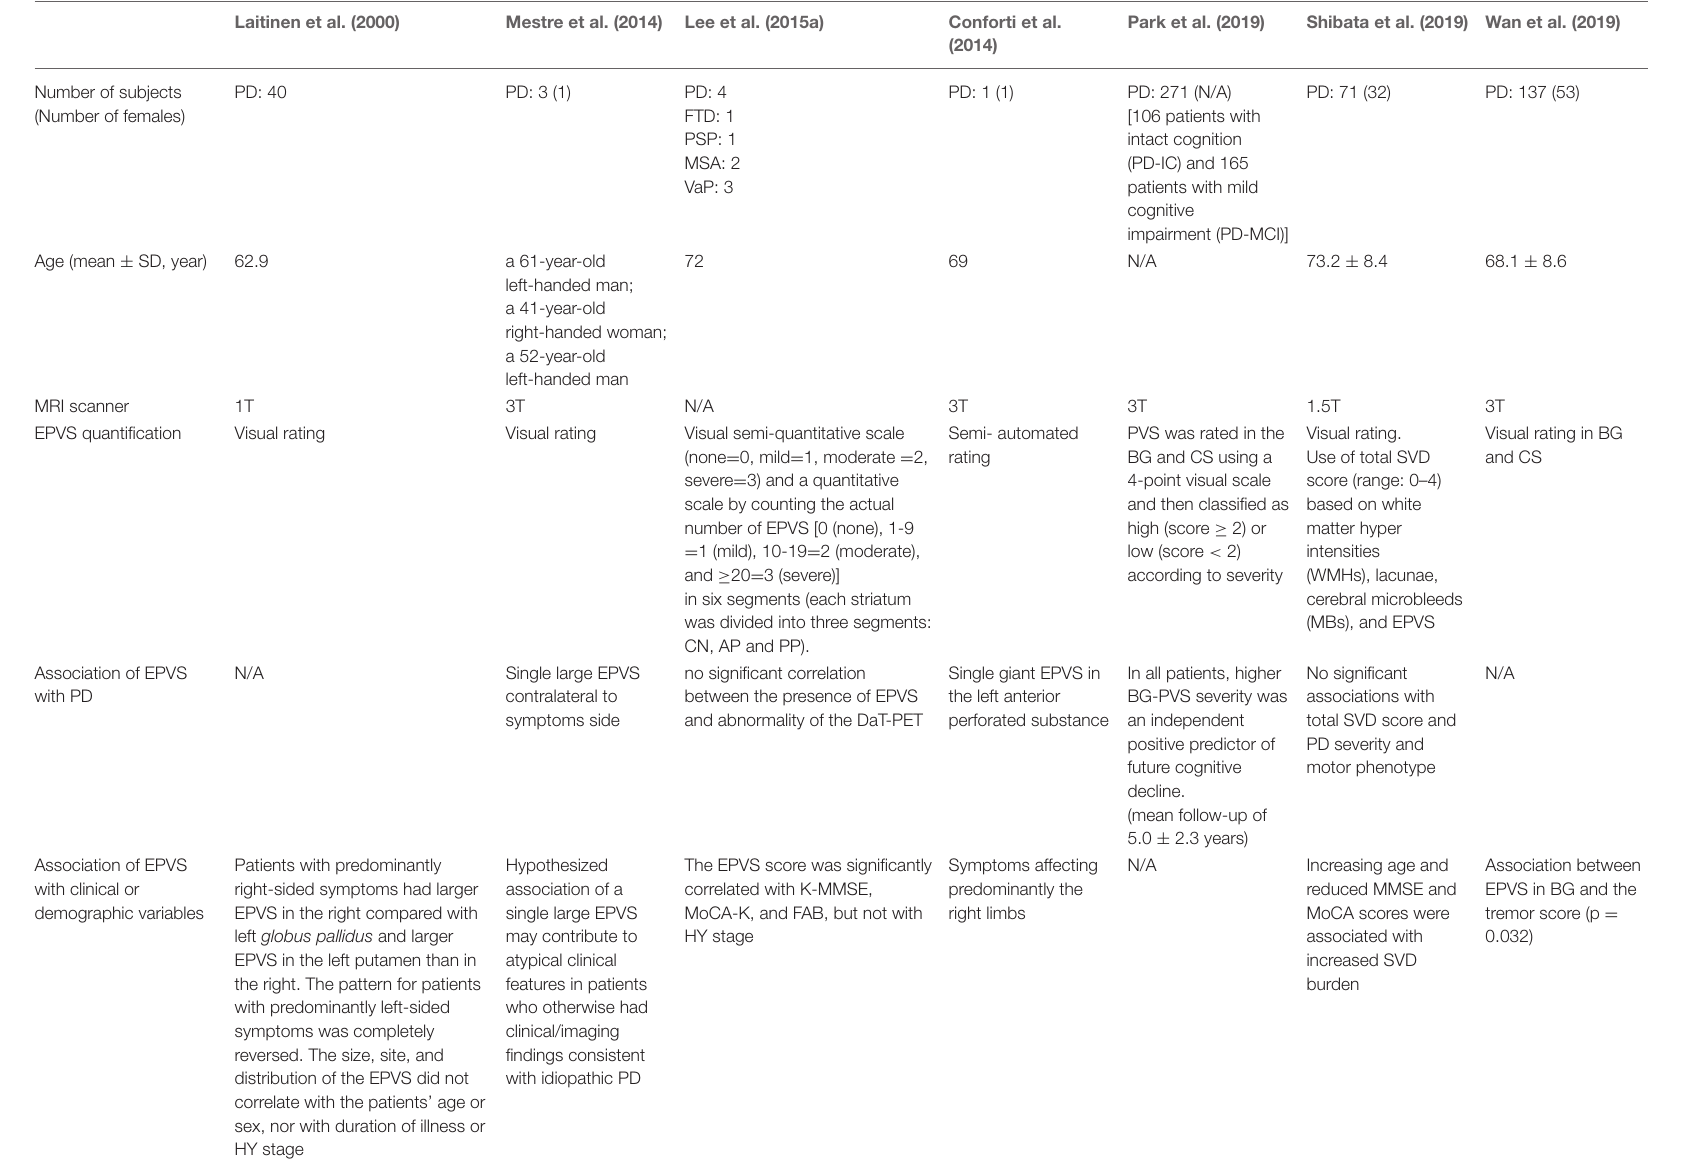
TABLE 2 | Clinical and MRI correlates of perivascular spaces in previous structural neuroimaging studies on patients with Parkinson’s Disease. Laitinen et al.